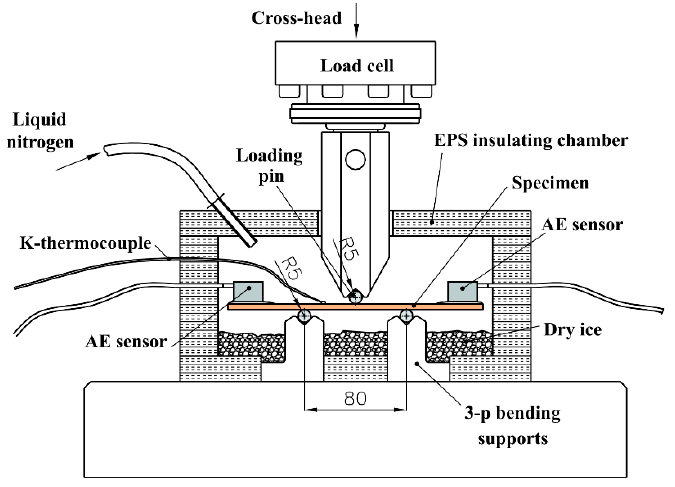
Figure 2. Experimental